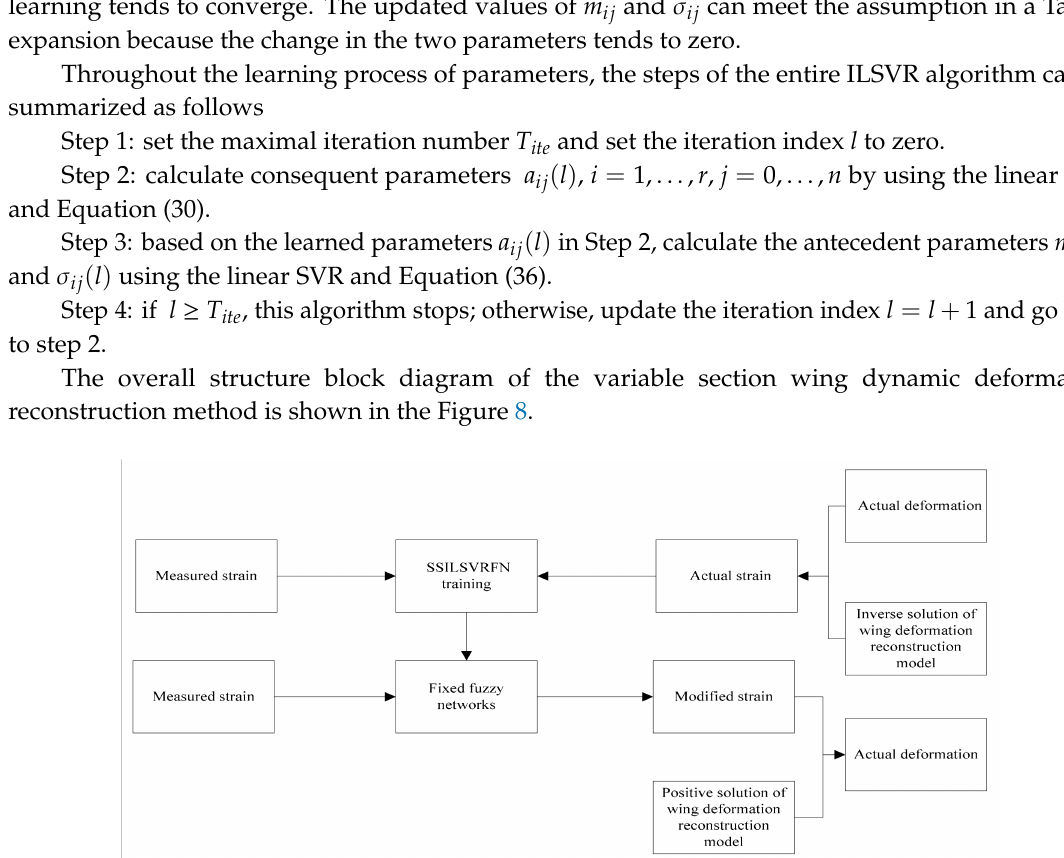
Figure 8. Structural block diagram of dynamic deformation reconstruction method for variable section